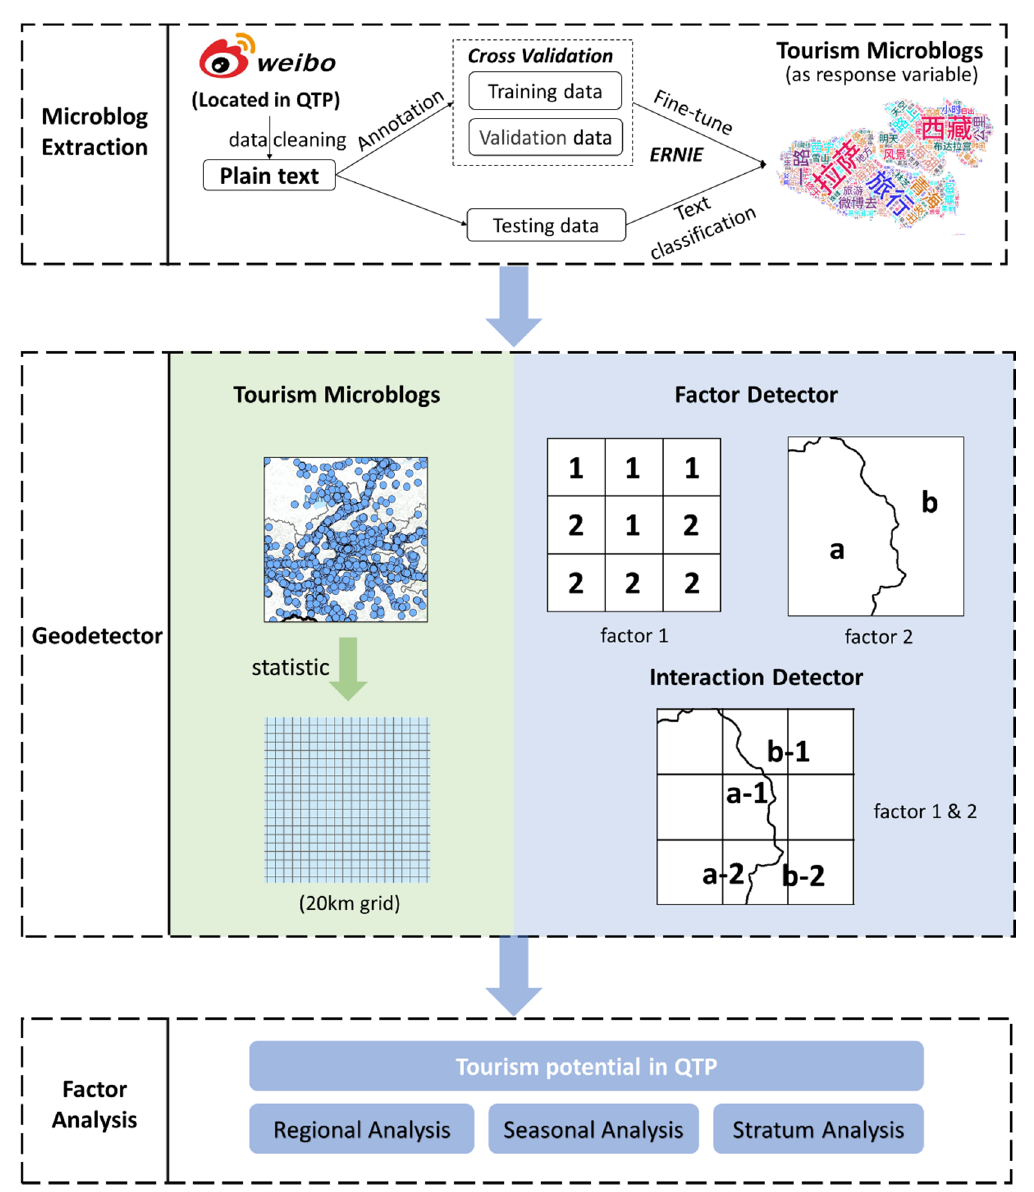
Figure 4. Research framework and workflow.